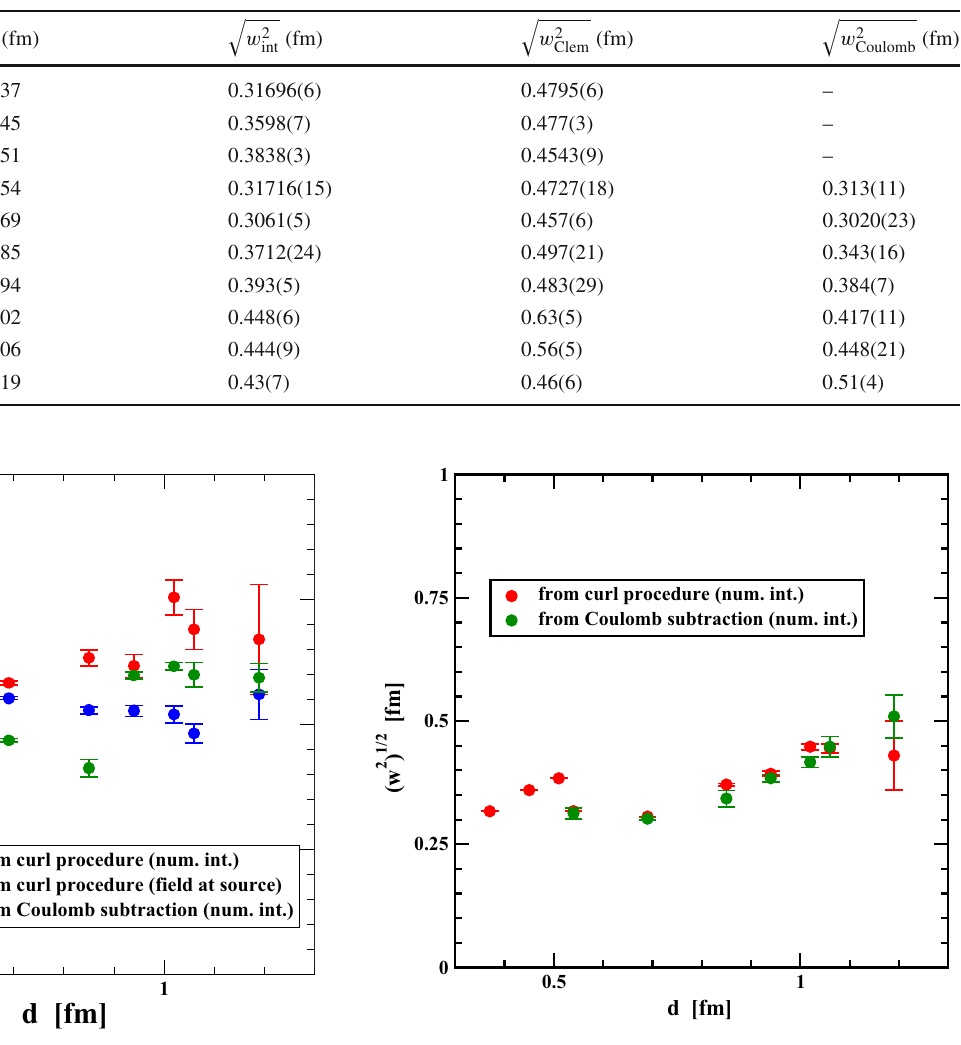
we report also the value of the width obtained by numerically integrat- ing Eq. (12) and using the non-perturbative field from the Coulomb